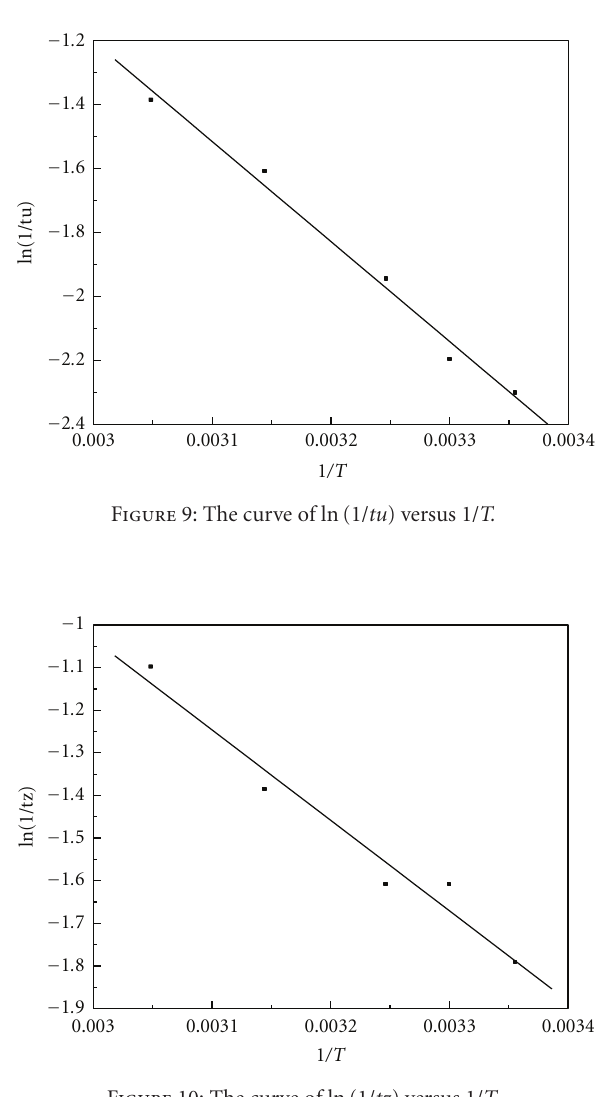
Figure 10: The curve of ln(1/ tz ) versus 1/ T.